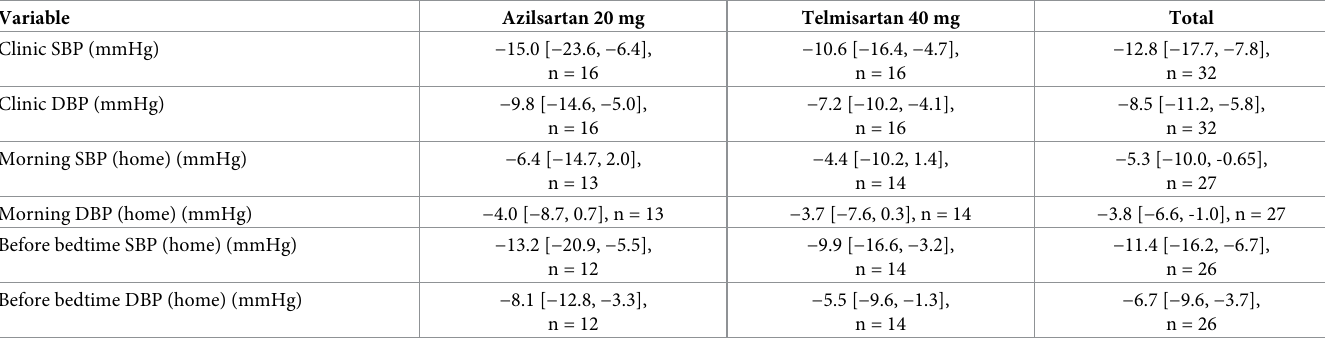
Table 5. Changes from the baseline values in blood pressure at the end of the treatment period (FAS).